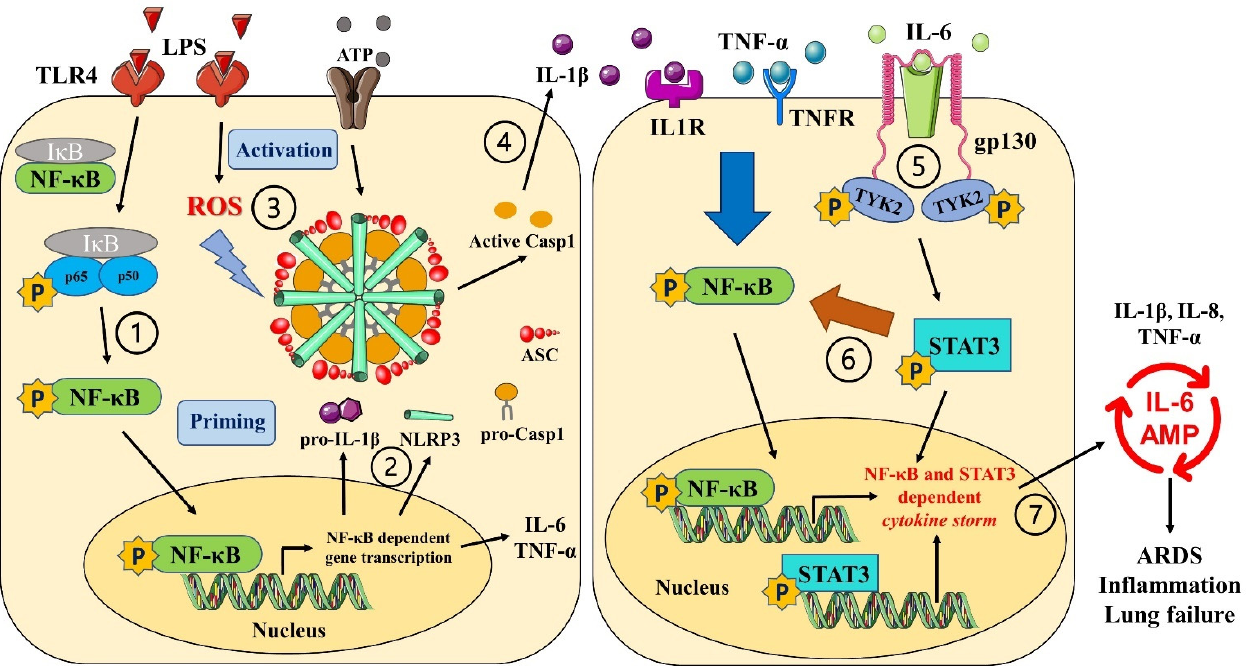
Figure 7. Summary of anti-inflammatory pathways activated by CBD and THC to curb LPS-induced cytokine storm: 1 (cid:13) . LPS activates TLR4 receptors which in turn phosphorylates NF- κ B. Phosphory- lated NF- κ B moieties translocate to the nucleus, thereby upregulating the expression of variety of pro-inflammatory genes. 2 (cid:13) . This TLR4-NF κ B-mediated “priming” (increased expression of NLRP3, pro-IL-1 β , and pro-caspase-1) is the first step in the activation of NLRP3 inflammasome. 3 (cid:13) . LPS also induces oxidative stress causing higher levels of ROS which in turn act as second “activation” signal leading to NLRP3 inflammasome assembly and activation. 4 (cid:13) . The NLRP3 inflammasome activation causes the release of mature IL-1 β leading to cell death via pyroptosis. 5 (cid:13) . Along with inflammasome activation, NF κ B activation also increases the levels of variety of other pro-inflammatory cytokines including IL-6. IL-6 binds to its receptors coupled to transmembrane protein, gp130, which in turn, in part, phosphorylates TYK2. 6 (cid:13) . Phosphorylated TYK2, in turn, phosphorylates STAT3 leading to the translocation of the latter to the nucleus. Phosphorylated STAT3 furthermore potentiates NF κ B activation. 7 (cid:13) . Nuclear translocation of STAT3 and NF κ B activate gene expression of various pro-inflammatory cytokines leading to cytokine release syndrome or cytokine storm. This cytokine storm activates vicious cycle of IL-6 amplification (IL-6 AMP) which is implicated in chronic inflammation, tissue injury, and organ damage. Our in vitro data revealed that CBD and THC block all the steps numbered in the figure above in both THP-1 macrophages (immune cells) and primary human bronchial epithelial cells (non-immune cells).